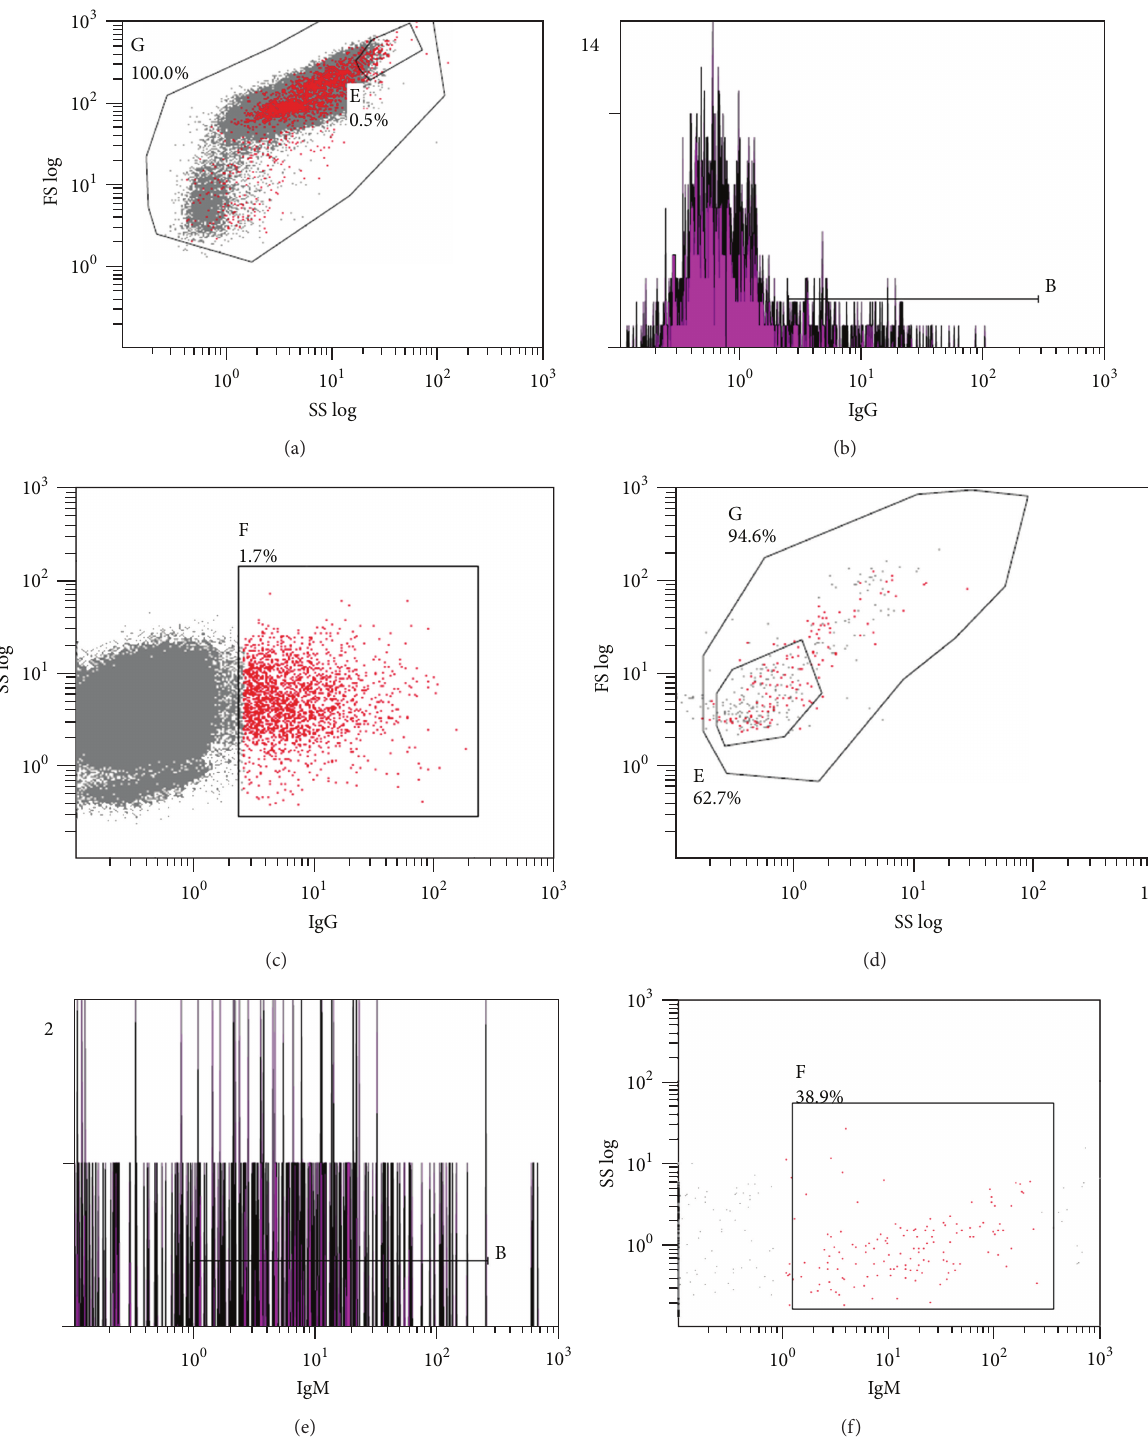
Figure 3: Cytofluorometric evaluation of anti-platelets and anti-red blood cells antibodies. (a) Forward versus side scatter plot showing the placement of the erythrocyte gate (E). (b) Fluorescence intensity histogram of the erythrocyte membrane-anti-RBC IgG bond. Negative and positive fluorescence peaks on the left and on the right, respectively. (c) Percentage of erythrocyte membrane binding IgG (F). (d) Forward versus side scatter plot showing the placement of the platelet gate (E). (e) Fluorescence intensity histogram of the platelet membrane-anti-PLT IgM bond. Negative and positive fluorescence peaks on the left and on the right, respectively. (f) Percentage of platelet membrane binding IgM